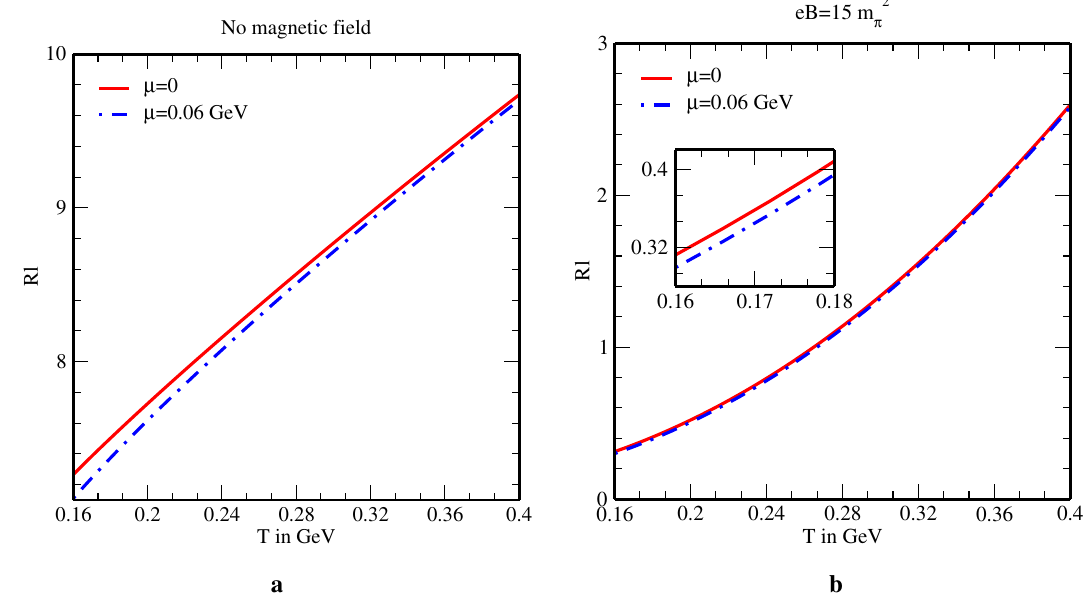
Fig. 6 Variations of the Reynolds number with temperature in the a absence and b presence of strong magnetic field